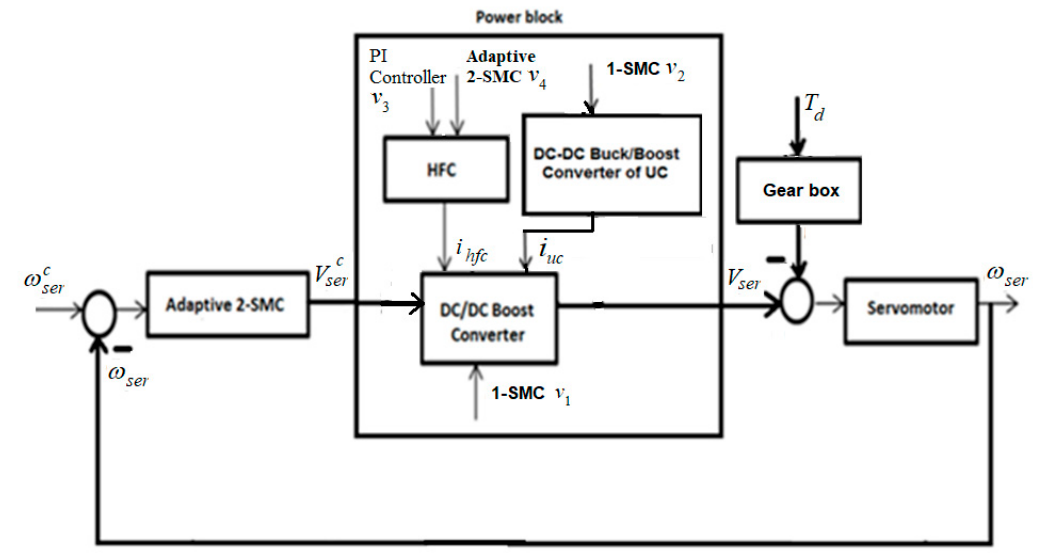
Figure 4. Schematic of the HFC / DC-DC / UC / servomotor electric power system for an electric vehicle application.